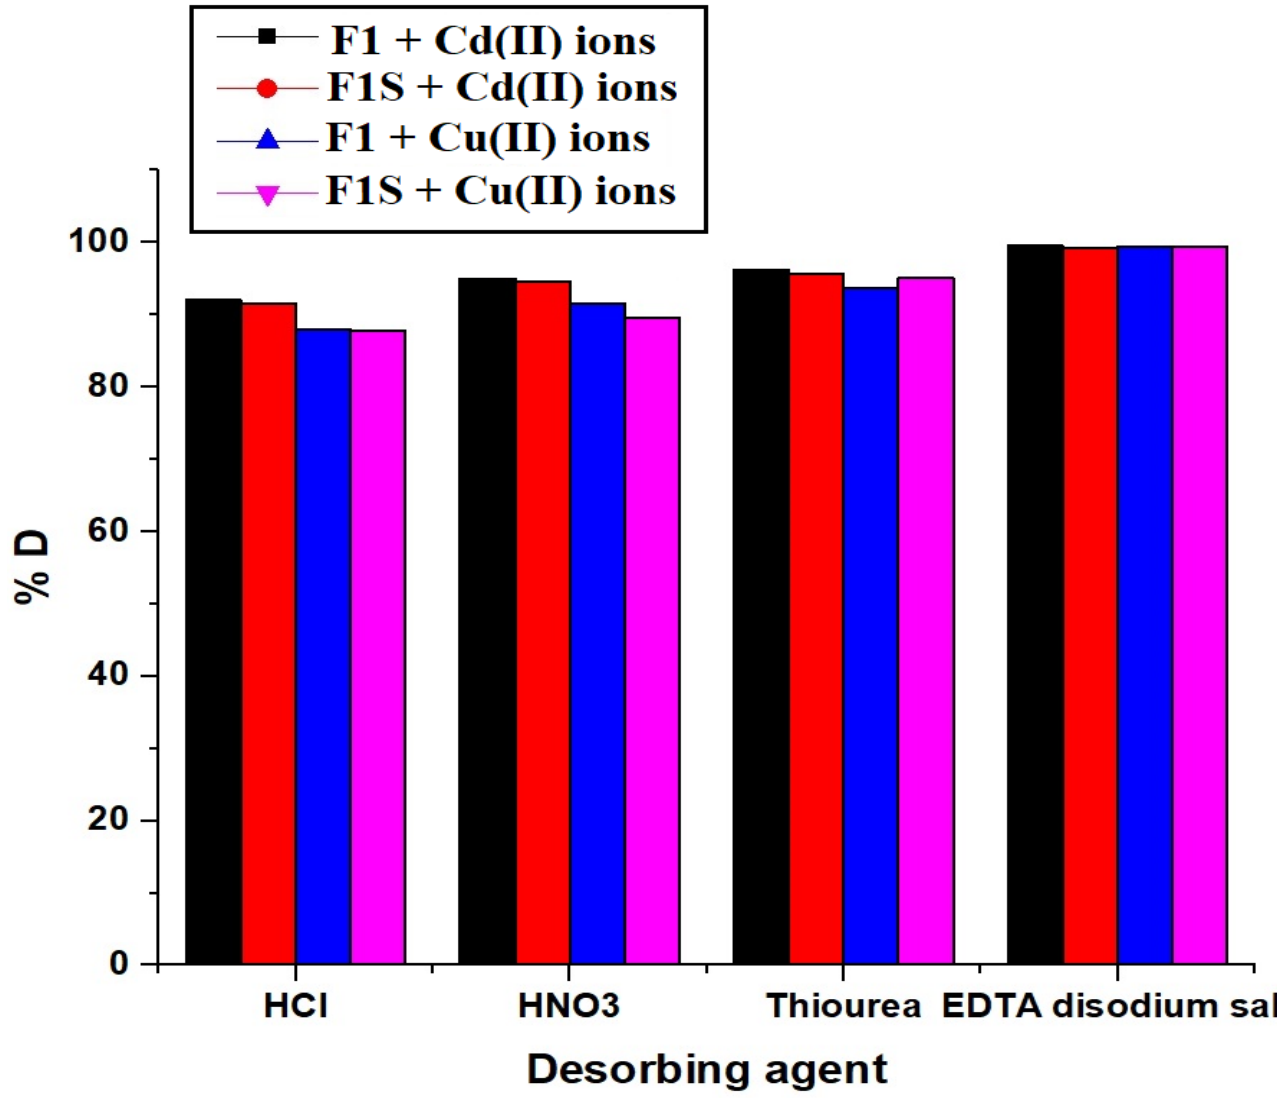
Figure 16. Desorption of copper and cadmium ions from the F1 and F1S samples using several eluting agents. Experimental conditions: concentration = 5 mg/L, volume of copper or cadmium solution = 40 mL, amount of adsorbent = 0.04 g, volume of eluting agent = 4 mL, temperature = 298 K, pH = 7.5, and time = 80 min.